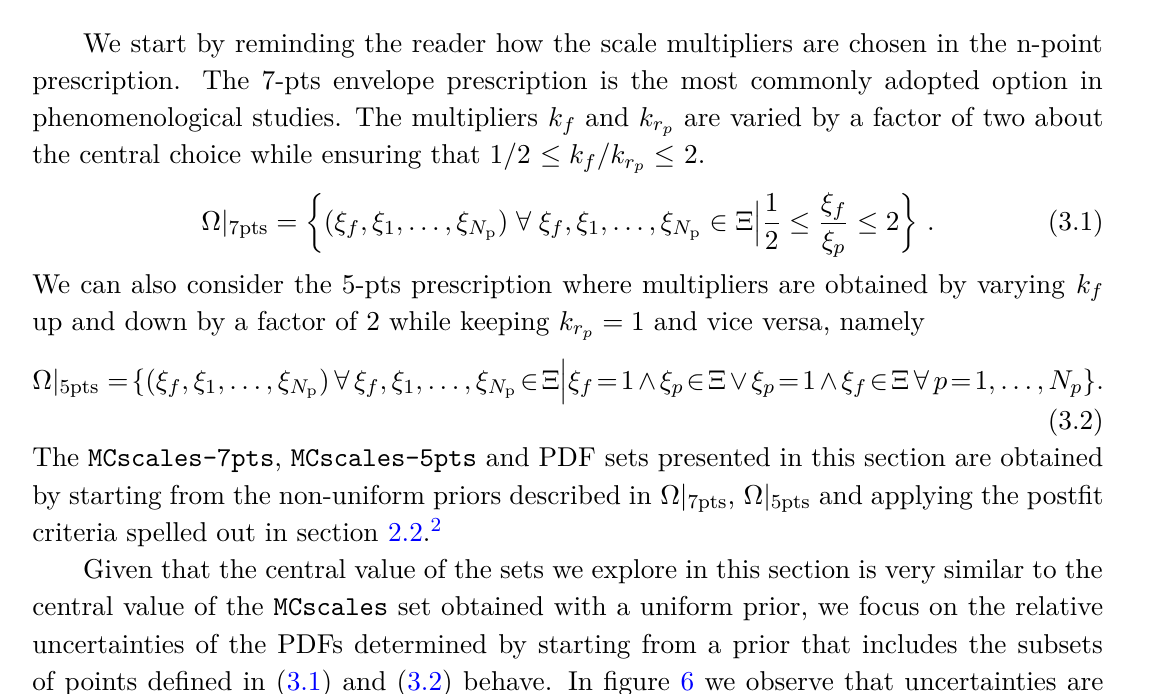
Figure 6 . Plots of the relative uncertainties of the gluon (top left), singlet Σ (top right), up (bottom left) and down (bottom right) PDFs at Q = 10 GeV once the prior probability is chosen according to the subset of scale choices defined in eq. (2.2) (blue curves), (3.1) (orange curves) or (3.2) (green